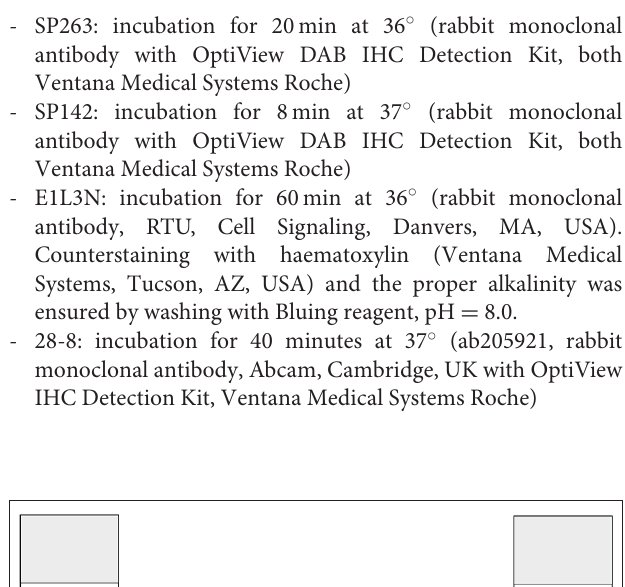
Frontiers in Medicine |